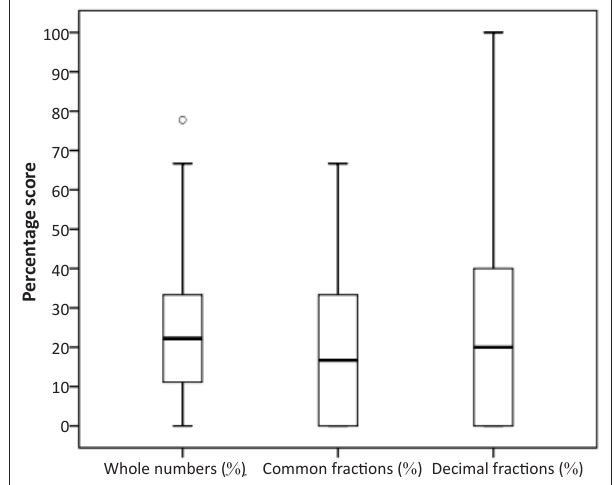
FIGURE 1: Distribution of scores for the three number domains on the mental calculations